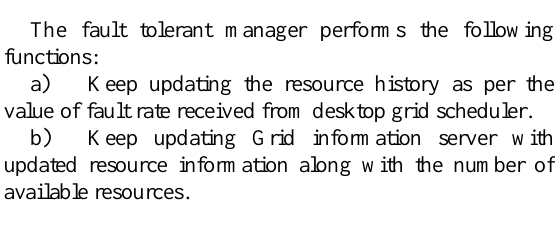
table. Thus fault Rate (Fr) of jth resource